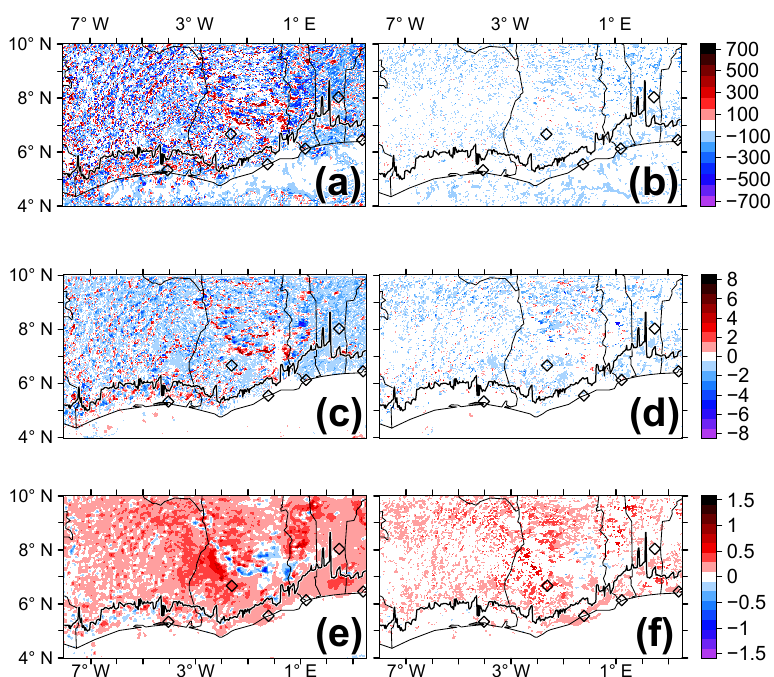
Figure 13. Surface meteorological quantities over SWA on 2 July 15:00UTC as differences between the reference and the clean case (AE1.0– AE0.25), (a, c, e) including cloudy and cloud-free areas and (b, d, f) over areas that are simultaneously cloud free in the clean and reference case. (a, b) Surface net downward shortwave radiation difference (Wm − 2 ), (c, d) 2m temperature difference (K) and (e, f) sea level pressure difference (hPa). The black solid lines denote the location of the reference case AI front.